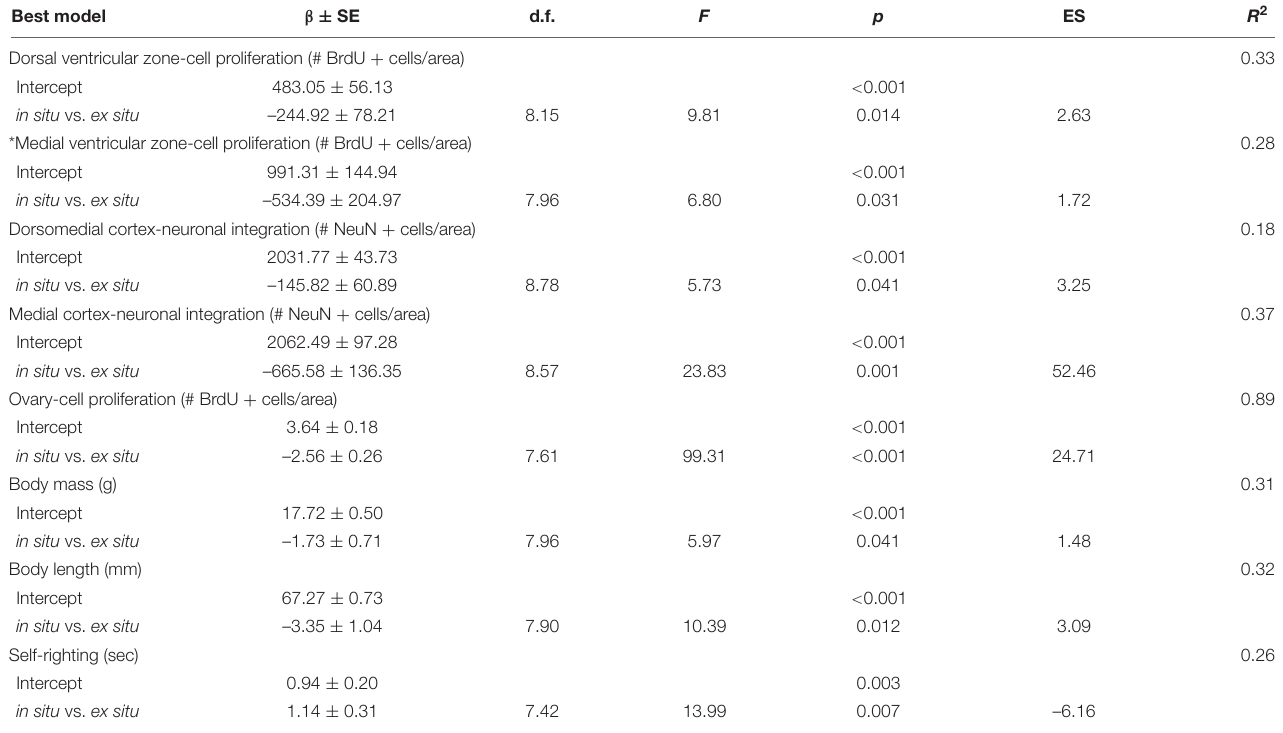
TABLE 2 | Summary of the best linear mixed effect models for each variable, selected by cAIC, explaining biological variables of Lepidochelys olivacea in situ vs. ex situ hatchlings. Best